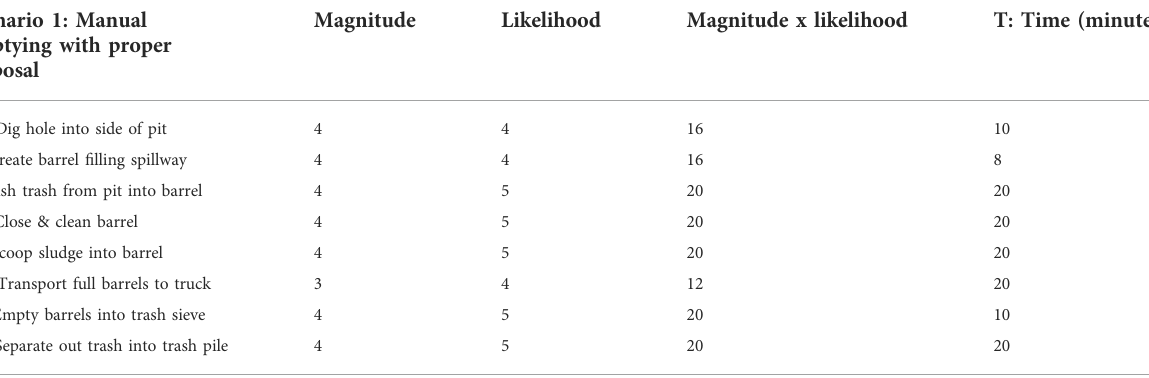
TABLE 3 Scenario 2, Excerpt of facial touch risk scores for vacuum truck emptying with proper disposal. Operator does not enter the truck for cleaning. Solid lines between rows denotes to a break in steps. See Supplementary Material for the complete set. Scenario 2: Vacuum truck emptying with proper